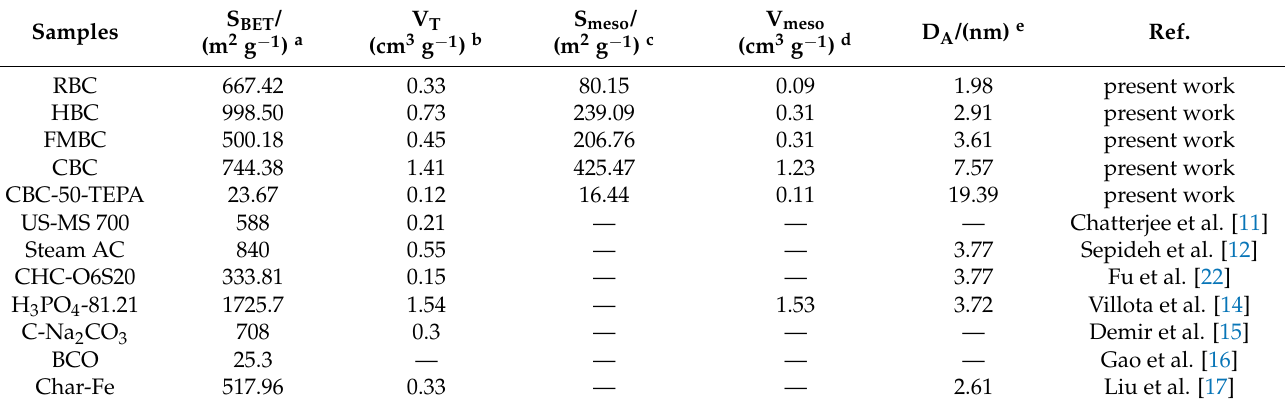
Table 2. Porous texture properties of biochar from different activation methods and CBC-50-TEPA.